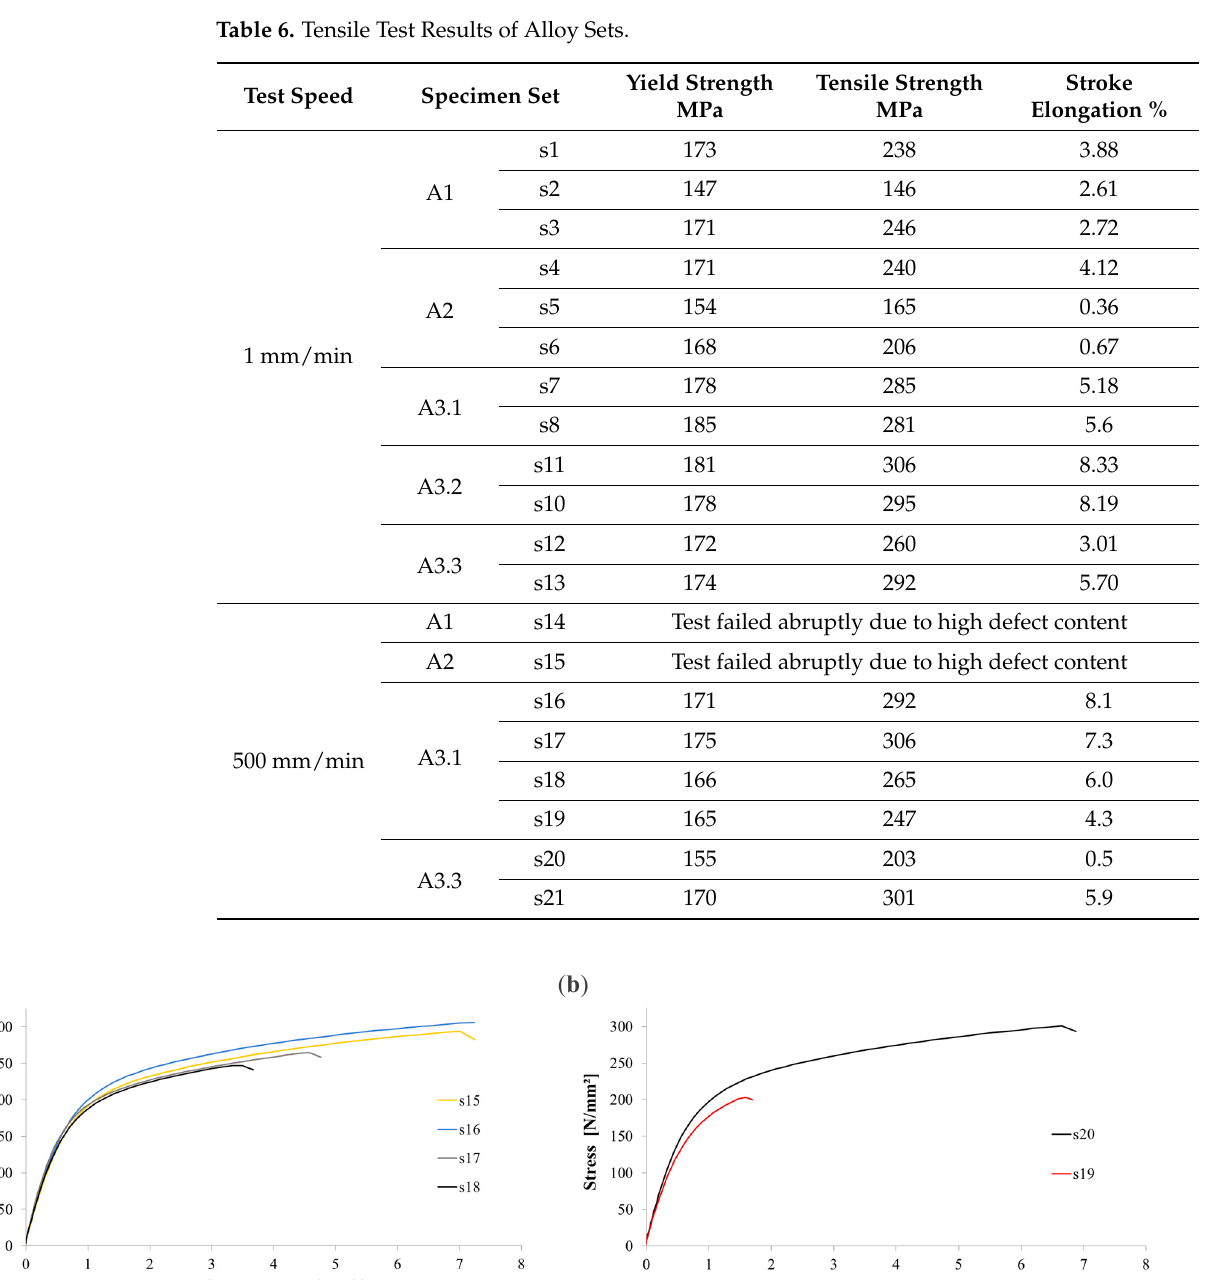
Figure 9. 500 mm-min Stroke Speed Tensile Test Results ( a ) A3.1 set ( b ) A3.3 set. Table 6. Tensile Test Results of Alloy Sets .